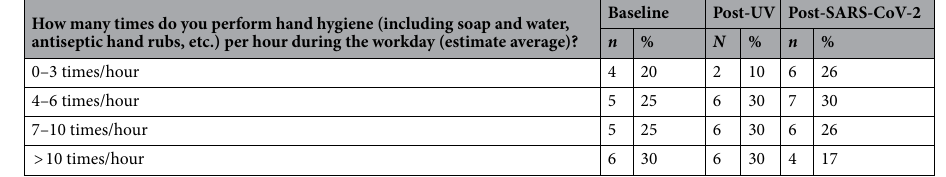
Table 1. Hand hygiene frequency among nursing staff in a medical surgical ward after ultraviolet intervention and during viral outbreak.